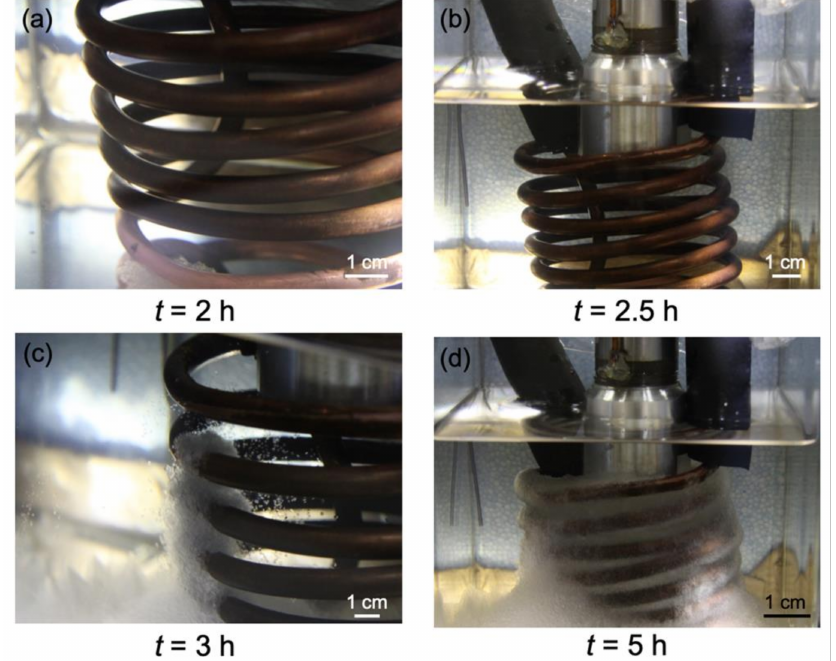
Figure 10. Optical observation changing in the container with ultrasonic vibration of 28 kHz. ( a – d ) are the pictures at 2 h, 2.5 h, 3 h and 5 h after cooling water started to be circulated, respectively.